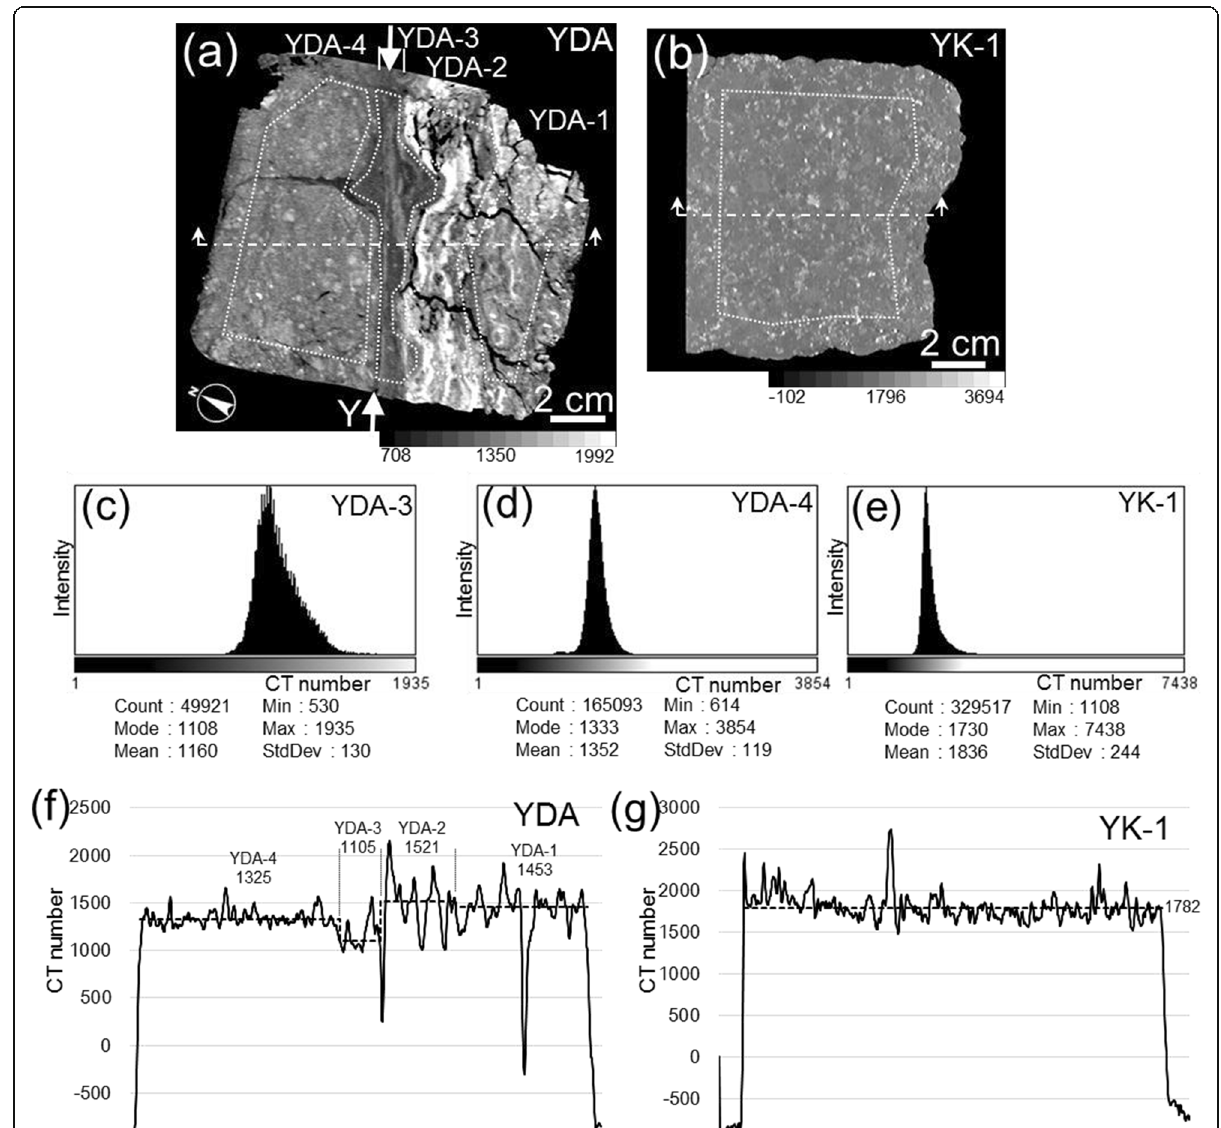
Fig. 9 X-ray CT image analysis results for the Mushu outcrop samples. CT images of the a YDA and b YK-1 samples. CT number histograms for c YDA- 3, d YDA-4, and e YK-1. The N CTM values were calculated near the center (within the white dotted lines in ( a ) and ( b )) of each zone, with the peripheral areas excluded. CT number profiles for f YDA and g YK-1, with the values calculated along the dash – dotted lines in ( a ) and ( b ),